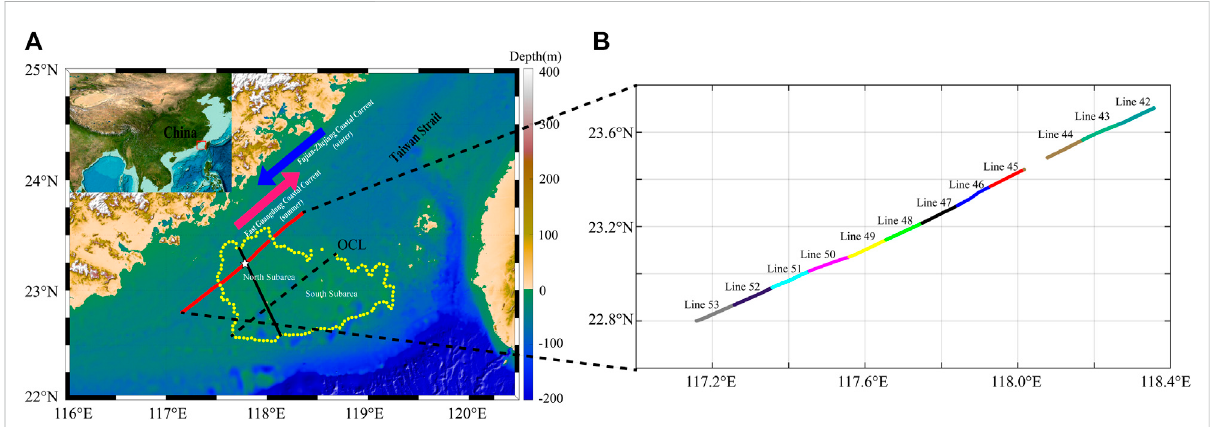
FIGURE 1 (A) A regional map showing the Taiwan Shoal (yellow dotted line), the two main coastal currents in the strait (thick red and blue arrows), the vessel ’ s path (red solid line, heading southwest), Zhou et al., 2018 ’ s multibeam survey track (solid black line) and their arbitrary Orientation Changing Limit (dashed black line). The white pentagram at the crossing (117.7757 ° E 23.2510 ° N) for the two survey lines is the location whose current velocity and direction data were used in the numerical modelling. (B) Close up of the multibeam survey data in this study. For the ease of plotting and presentations, the track line is divided into 12 sections, Line